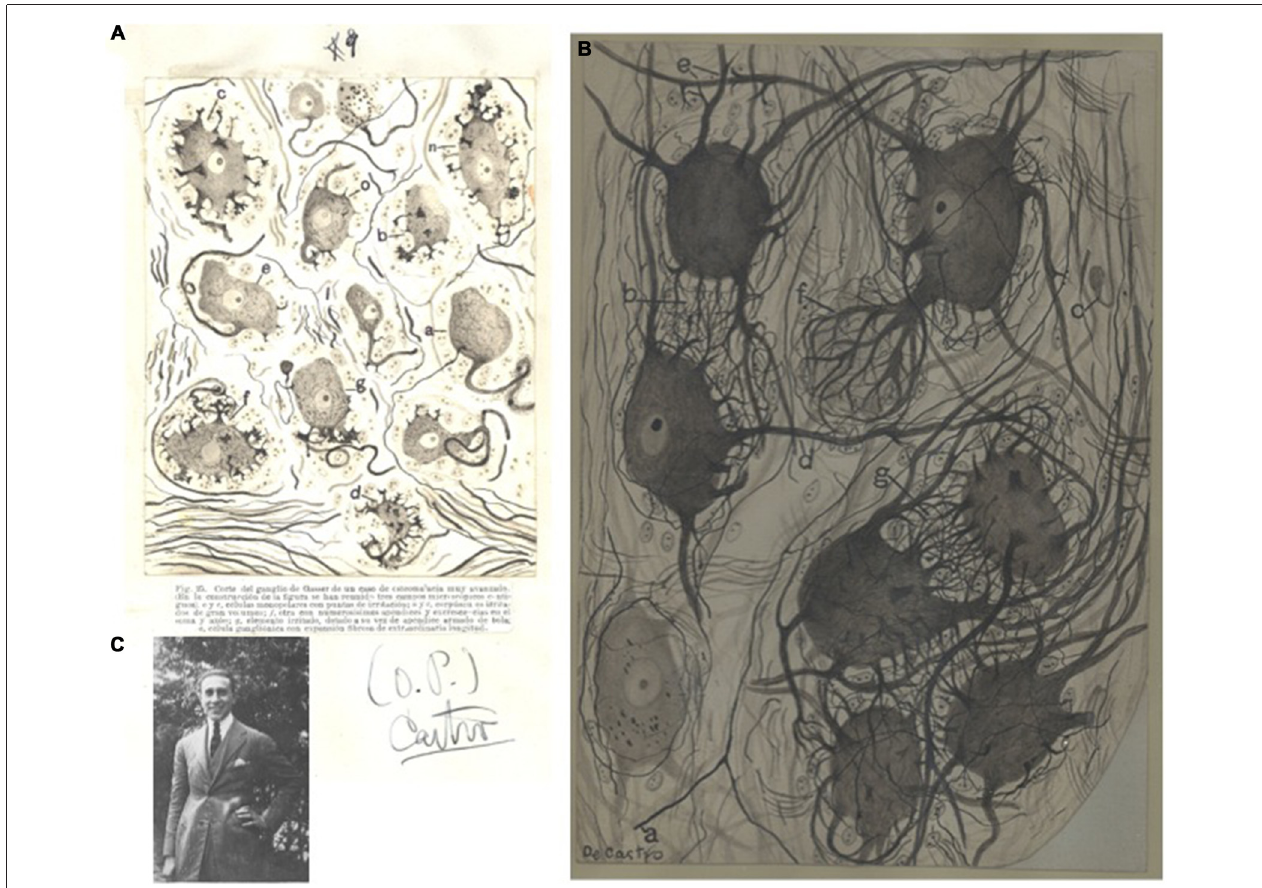
FIGURE 2 | First works of Fernando de Castro in the structure of the peripheral nervous system. (A) Image from the original PhD thesis of Fernando de Castro, with his hand-drawn illustrating some pathological forms of neurons from the Gasser’s ganglion from a patient of osteomalacia. The typewritten figure legend (in Spanish) for the defense of the thesis is conserved for the reader, as well as the signature from de Castro at that time. This figure was published in de Castro (1922). (B) de Castro’s original hand-sketch of a portion of a sympathetic lumbar ganglion in normal condition (human, 38-year old) originally stained with the Cajal’s method, and illustrating preganglionic ( a ) and intraganglionnic endings ( d ) over dendritic bushes, accesory dendrites forming bushes ( b,g ), a protoplasmic process forming collaterals ( c ) and a pericellular dendritic nest ( f ). This schema was published in de Castro (1923c, 1933). (C) Image of a young Fernando de Castro (1922) at his family house in Cercedilla, in the mountains close to Madrid (A–C) are part of Archive Fernando de